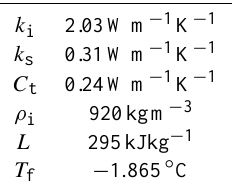
Table 2. Parameters for the freezing-degree-day model: Eq. (1).